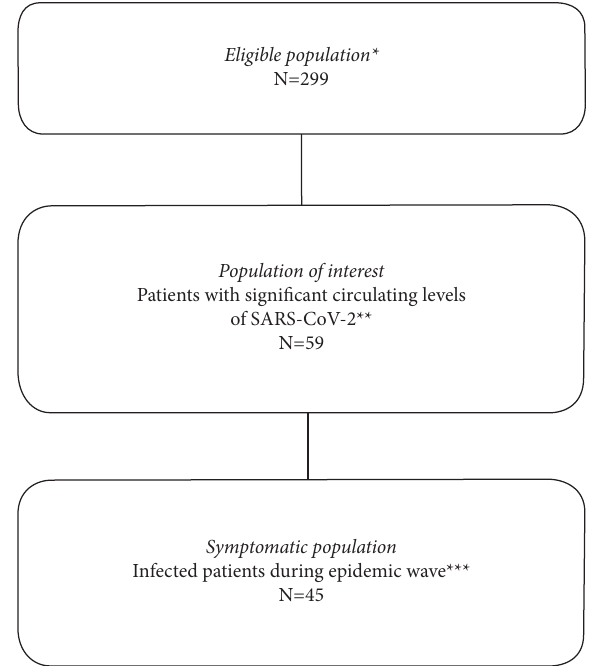
Figure 1: Flow chart of the different populations. ∗ Patients in maintenance hemodialysis during the first wave of the epidemic, March–April 2020, and still living 6 months later. ∗∗ 6 months after the first wave of the epidemic. ∗∗∗ RT-PCR positive ( n � 25) or typical symptoms of the disease with biological abnormalities ( n � 1) or typical pulmonary features on the chest scan ( n �